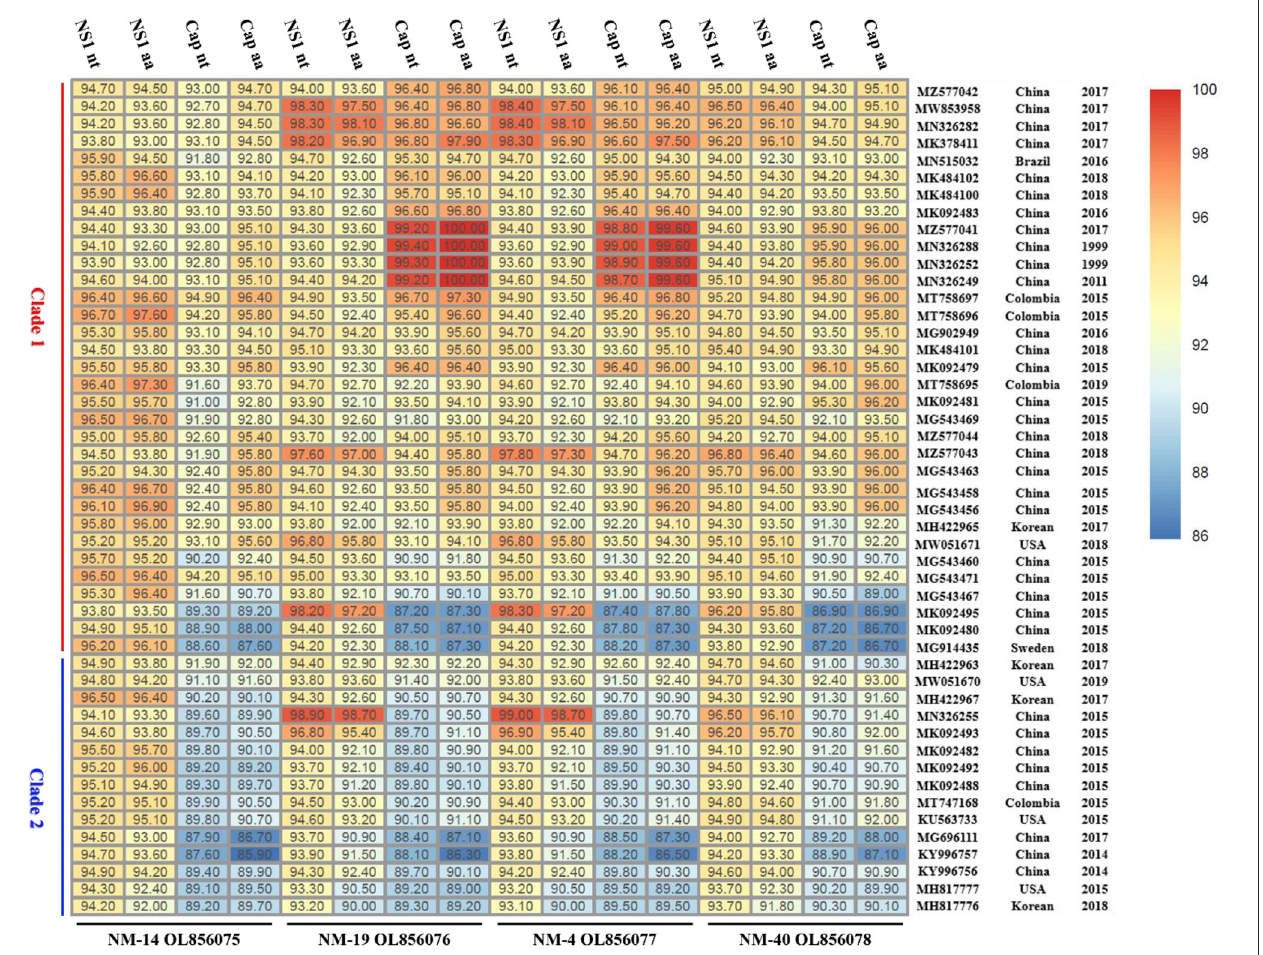
FIGURE 4 | The nucleotide (nt) and amino acids (aa) similarity between the NS1/Cap of the four PPV7 isolates and that of the reference strains. The GenBank accession number, country, and year of the reference sequences are noted on the right of the figure. The sequences of the four strains shared 93.1–99.0% similarity in the NS1 nt, 90.0–98.7% similarity in the NS1 aa, 86.9–99.4% similarity in the capsid nt and 85.9–100% similarity in the capsid aa sequence compared with the 48 reference strains.